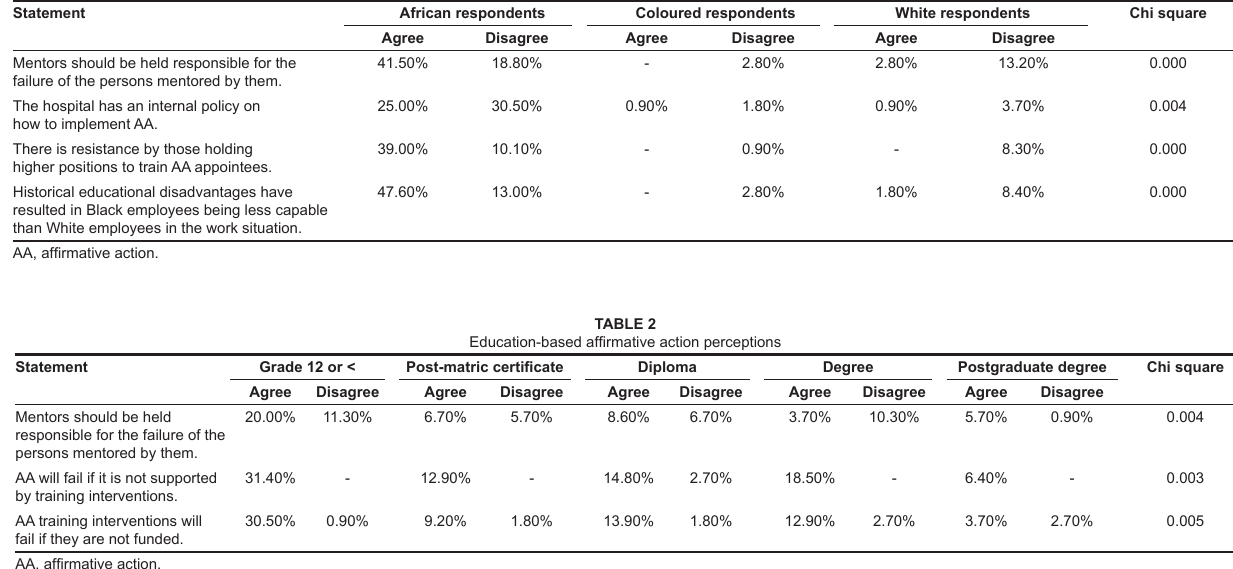
TABLE 1 Race-based affirmative action perceptions